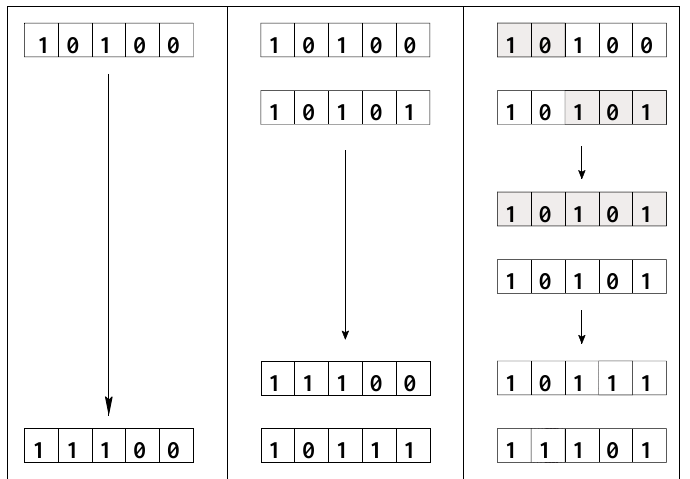
Fig. 2a – Schematic representation of the genomic changes forAS,AP, MP (from left to right).